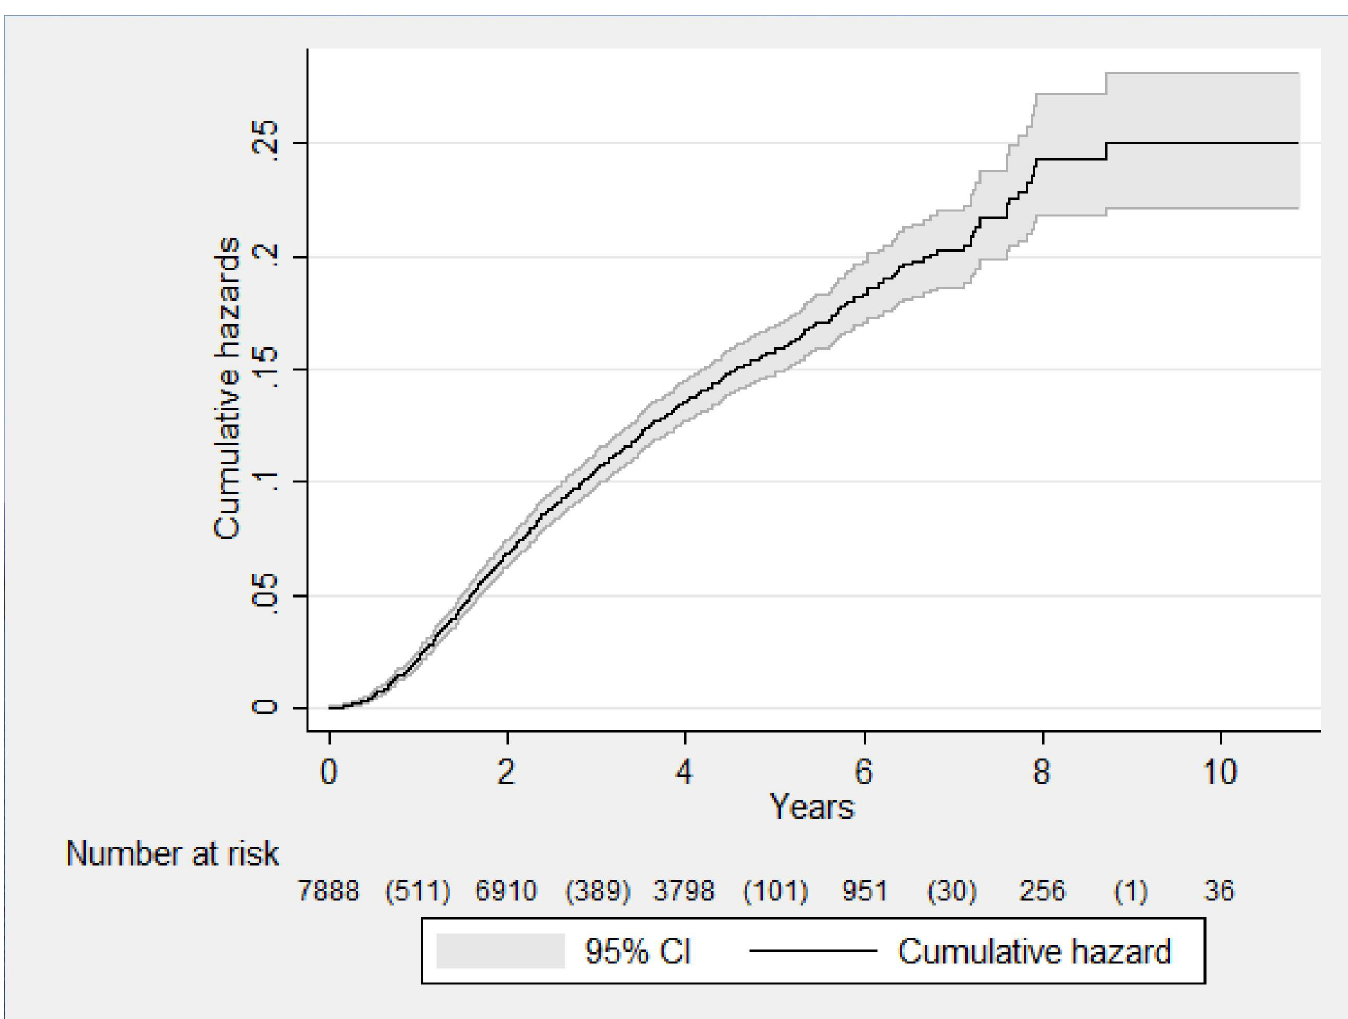
Fig 1. Nelson Aalen curve showing the cumulative hazard of virological failure in patients on first-line ART initiated at Integrated HIV Care program, Myanmar, between 2005 and